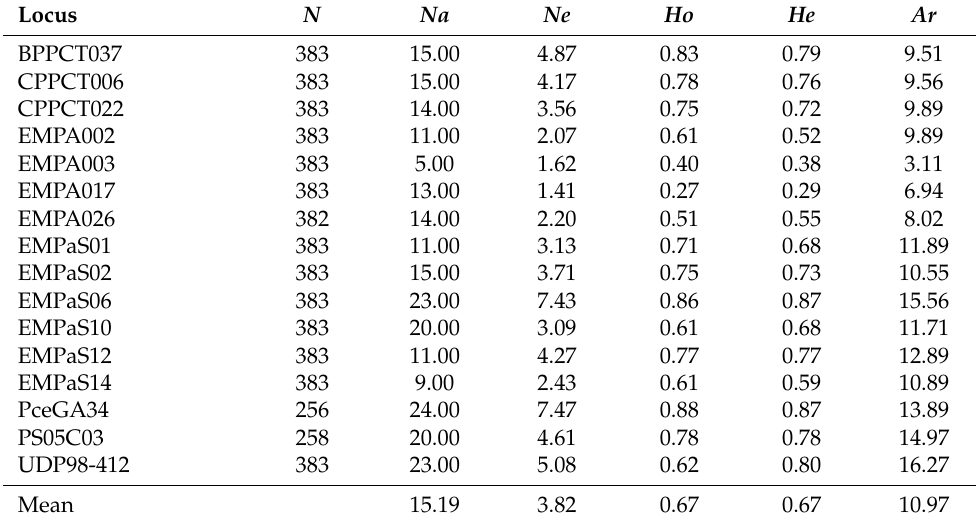
Mean 10.97 N = number of samples; Na : number of different alleles; Ne : number of effective alleles (=1/( ∑ p i 2 )); p i : relative fre- quency of the ith allele; Ho : observed heterozygosity (=number of heterozygotes/N); He : expected heterozygosity (=1 − ∑ p i 2 ); Ar = Allelic richness. The probability of identity was low for most SSRs (mean PI = 0.18) and ranged from PI = 0.52 (EMPA017) to PI = 0.03 (PceGA34 and EMPaS06), indicating a high discrimination power of the used SSR markers (Figure 2). Taking into account related individuals in the cherry collection, the mean PI sib was slightly lower at 0.46. Because low PI values indicate high marker efficiency, the best markers were PceGA34 and EMPaS06 (both PI = 0.03), UDP98-412 ( PI = 0.06), PS05C03, BPPCT037 (both PI = 0.07), and EMPaS12 ( PI = 0.09).